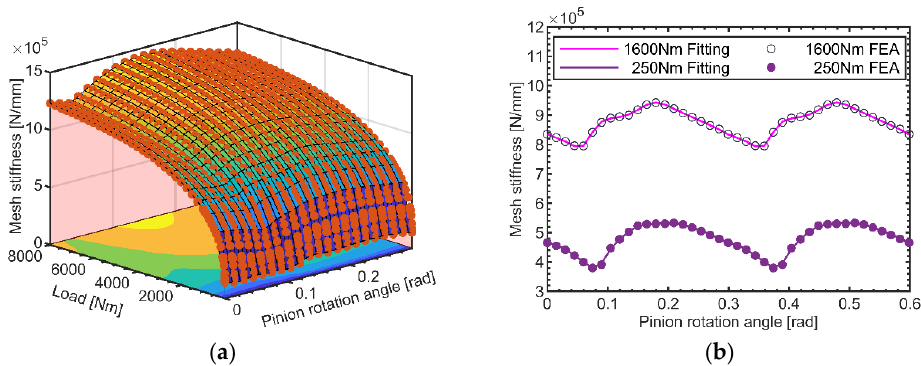
Figure 4. Mesh sti ff ness model of the lower face gear: ( a ) neural network model; ( b ) veri fi cation of Figure 4. Mesh stiffness model of the lower face gear: ( a ) neural network model; ( b ) verification of generalization capability. generalization